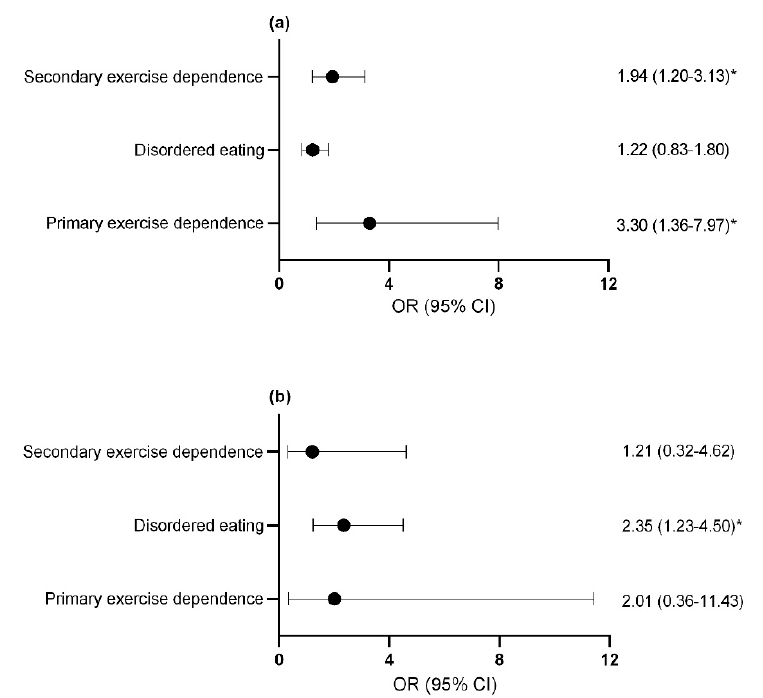
Figure 4. Odds ratio and confidence interval of at least 1 previous bone stress fracture in ( a ) females ( b ) males. * p < 0.05. exercise dependence, exercise dependence. OR, odds ratio; CI, confidence in- terval .